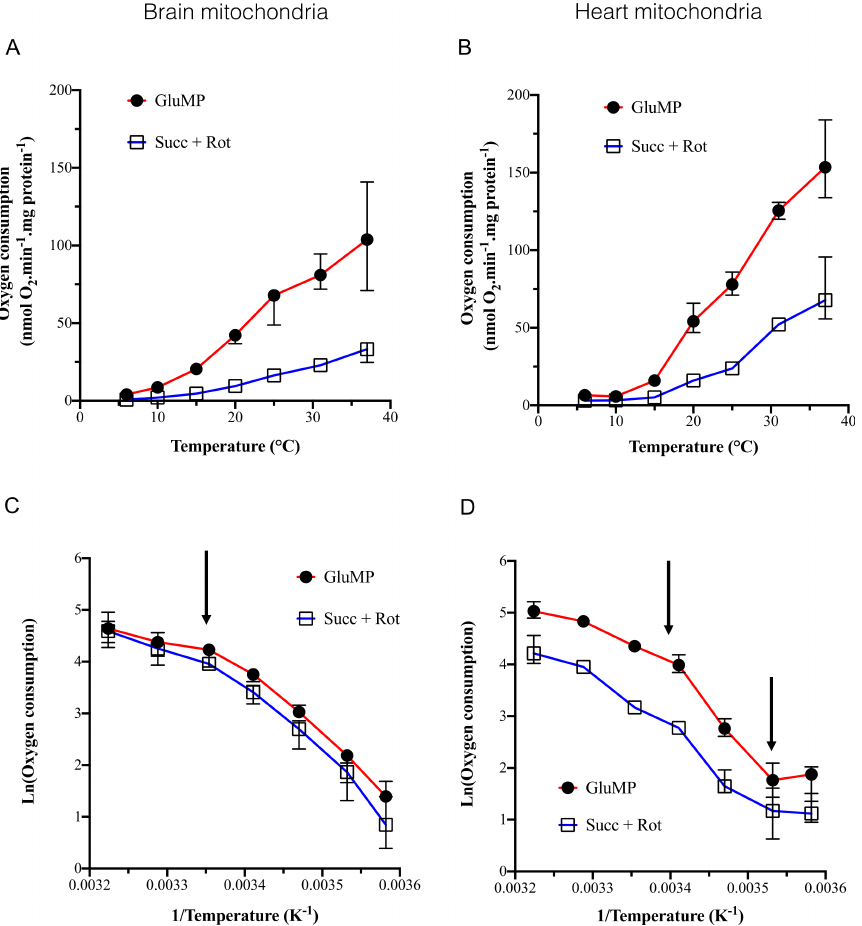
Figure 1. The dependance of mitochondrial oxygen consumption on the temperature. ( A ) Mito- chondrial oxygen consumption in brain mitochondria, in nmol O 2 /min/mg protein, according to temperature (6, 10, 15, 20, 25, 31, and 37 ◦ C). For each temperature, each experiment was